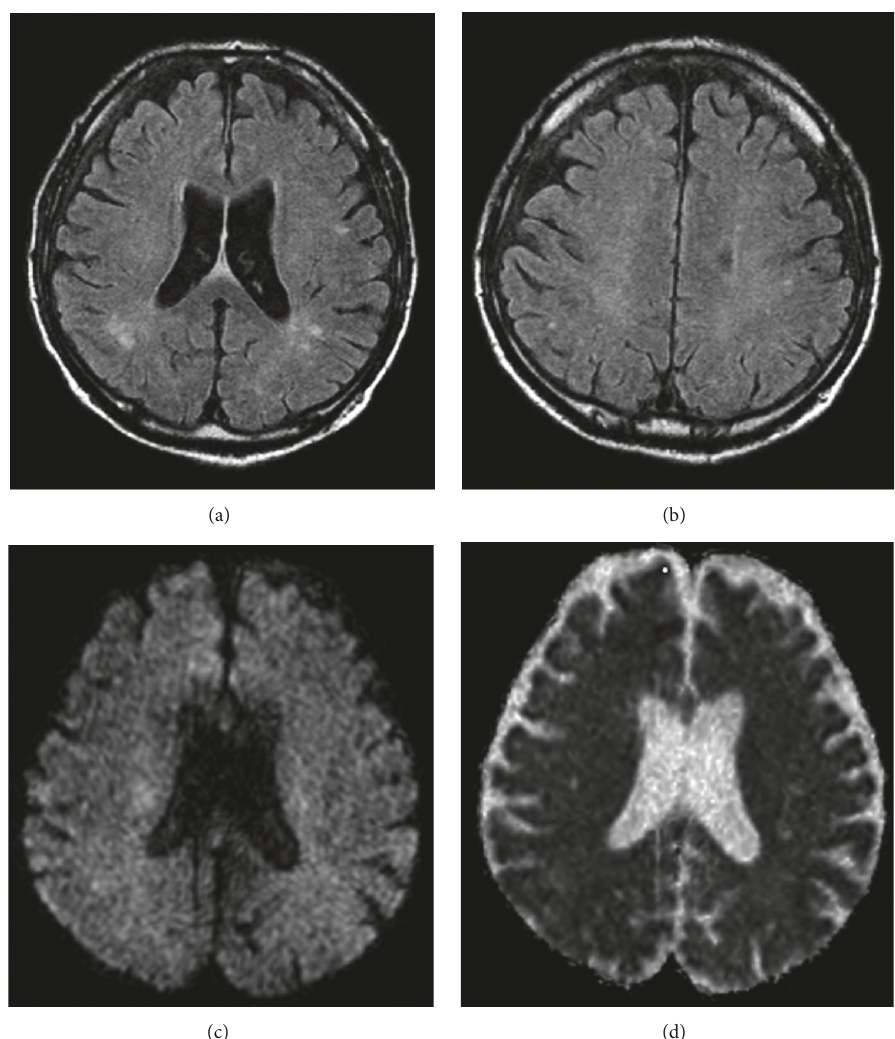
Figure 1: Cranial MRI on admission. ((a), (b)) Cranial T2-weighted fluid attenuated inversion recovery (FLAIR) MRI showing several old small brain infarctions. (c) Diffusion-weighted MR imaging (DWI) obtained on admission, showing no hyperintense signal alterations. (d) Apparent diffusion coefficient (ADC) mapping obtained on admission, showing no increased diffusion in cerebral